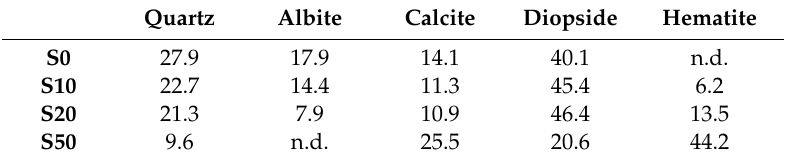
Table 2. Quantitative (wt%) mineralogical composition of the uncoated ceramic samples. Quartz Albite Calcite Diopside Hematite S0